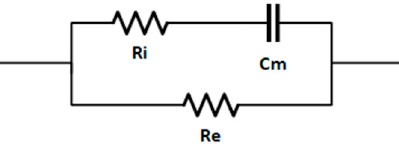
Figure 4. Fricke’s electrical model of biological tissue.